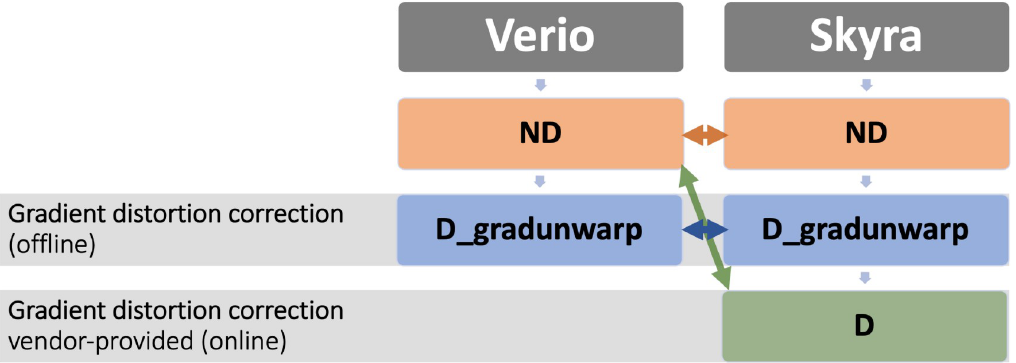
Fig 1. Overview of the acquisitions and the performed analyses. Orange: Main analysis comparing Verio ND and Skyra ND. Blue: Analysis of gradunwap Verio ND and Skyra ND. Green: Additional analysis of default scanner outputs Verio ND and Skyra